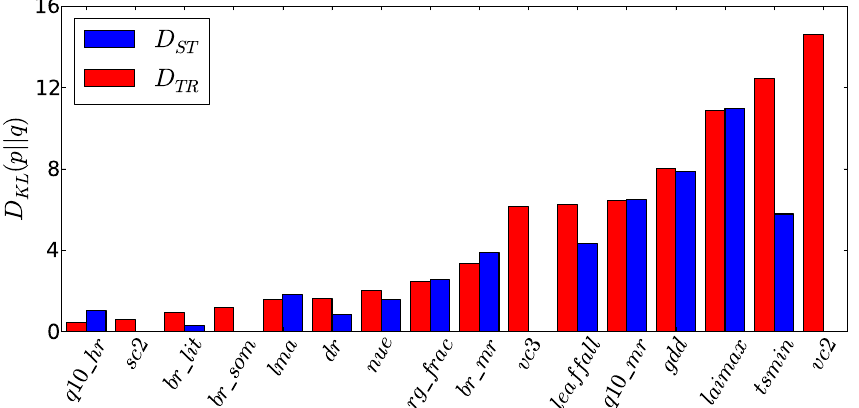
Figure 16. Kullback–Leibler divergence, D KL (p || q) , between prior q and posterior p densities for parameters with D KL > 0 . 5 for both D ST and D TR